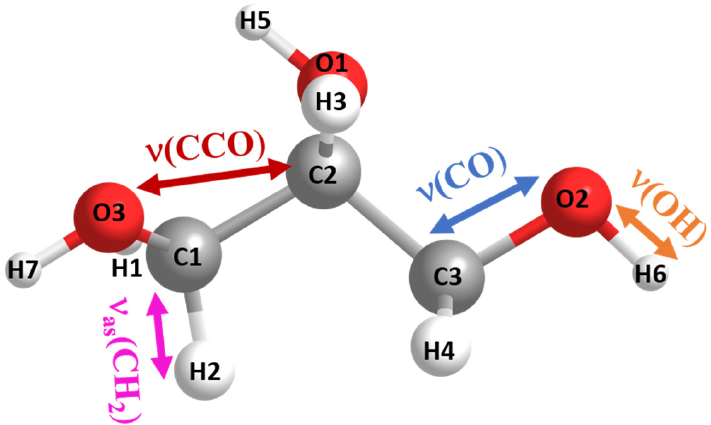
Figure 1. IR-active vibrations being involved in intra- and/or intermolecular interactions. The atomic charges (in electronic units) of the labeled atoms are according to [5]: O1: − 0.581, O2: − 0.585, O3: − 0.585, C1: 0.182, C2: 0.055, C3: 0.182, H1: 0.026, H2: 0.026, H3: 0.04, H4: 0.026, H5: 0.396, H6: 0.396, and H7: 0.396. The calorimetric glass transition temperature Tg of glycerol is 185 K.